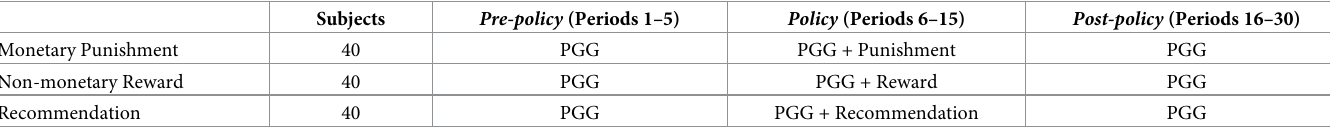
Table 1. Treatment